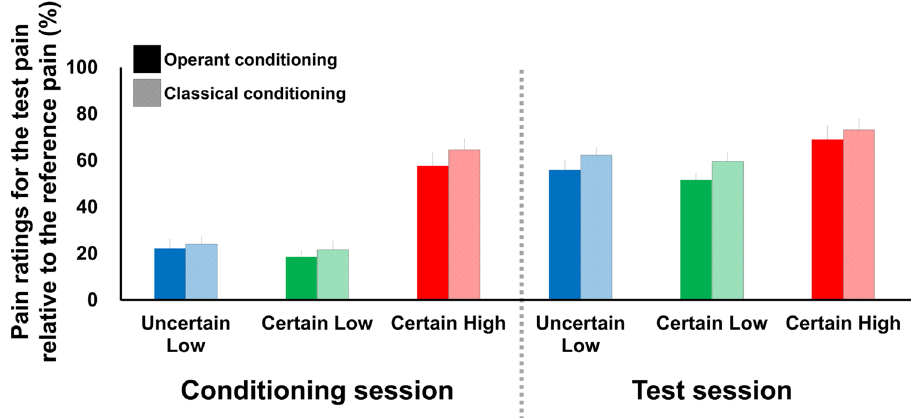
Figure 2. Pain ratings during the conditioning and test sessions on day 2. Bars represent the average relative pain ratings in response to the second pain stimulus relative to the reference pain, and error bars represent between-subject standard errors. Significant main effects of type of learning ( p = 0.04; Cohen’s f = 0.17, 95% confidence interval [0.03, 0.30]) and visual cues ( p = 2e−16; Cohen’s f = 0.63, 95% confidence interval [0.48, 0.77]) were determined by two-way ANOVA. The post hoc t -tests with Bonferroni correction showed that the pain ratings were significantly lower in operant than in classical learning trials (operant vs. classical learning: t = −2.011, p = 0.045). Additionally, the intensity ratings of pain experienced with the 256 mN pinprick needle following the UL and CL cues were significantly lower than those for the same painful stimulus (the 256 mN needle) following the CH cue (UL vs. CH: t = 7.573, p = 4.7e−09; CL vs. CH: t = 8.588, p = 3.8e−11). There was no significant difference in the intensity of pain between the UL and CL trials ( t = −1.043; p =